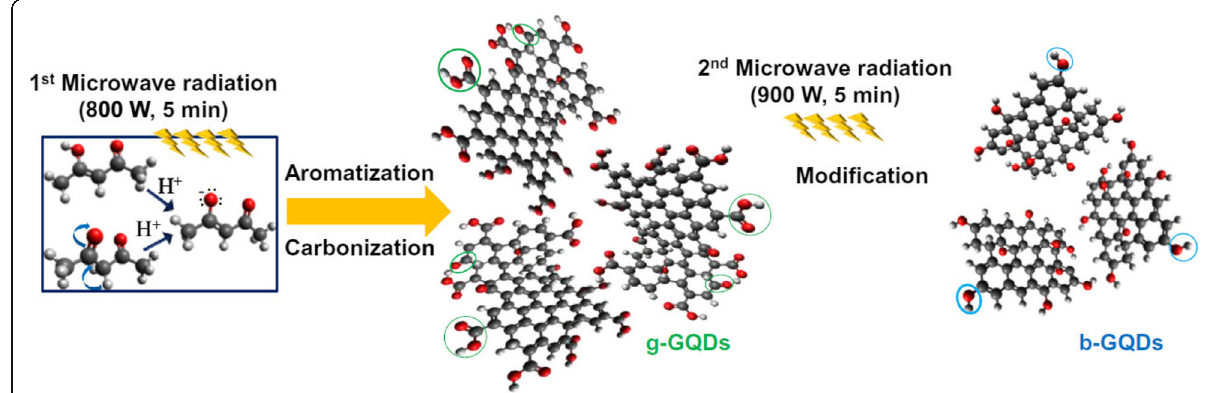
Fig. 7 Schematic illustration of microwave bottom-up route for green-GQDs and blue-GQDs: green circles indicate carboxyl and carbonyl groups, and blue circles indicate hydroxyl groups